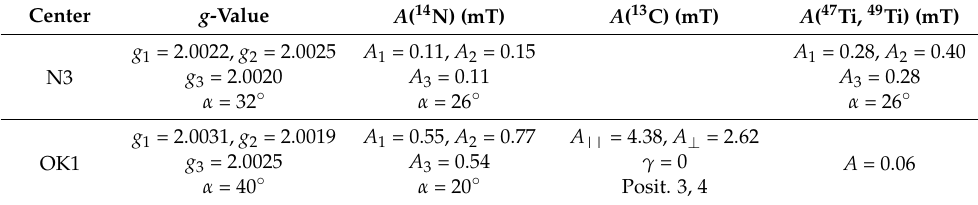
Table 3. Electron paramagnetic resonance (EPR) parameters for titanium-containing centers with S = 1/2 in diamond. g 1 ( A 1 ) corresponds to (1–10), α is the angle between g 2 ( A 2 ) and (110). γ is the angle between A 1 and (1-1-1) or (-11-1) that rotates towards (1–10), A 2 is perpendicular to the (110) plane